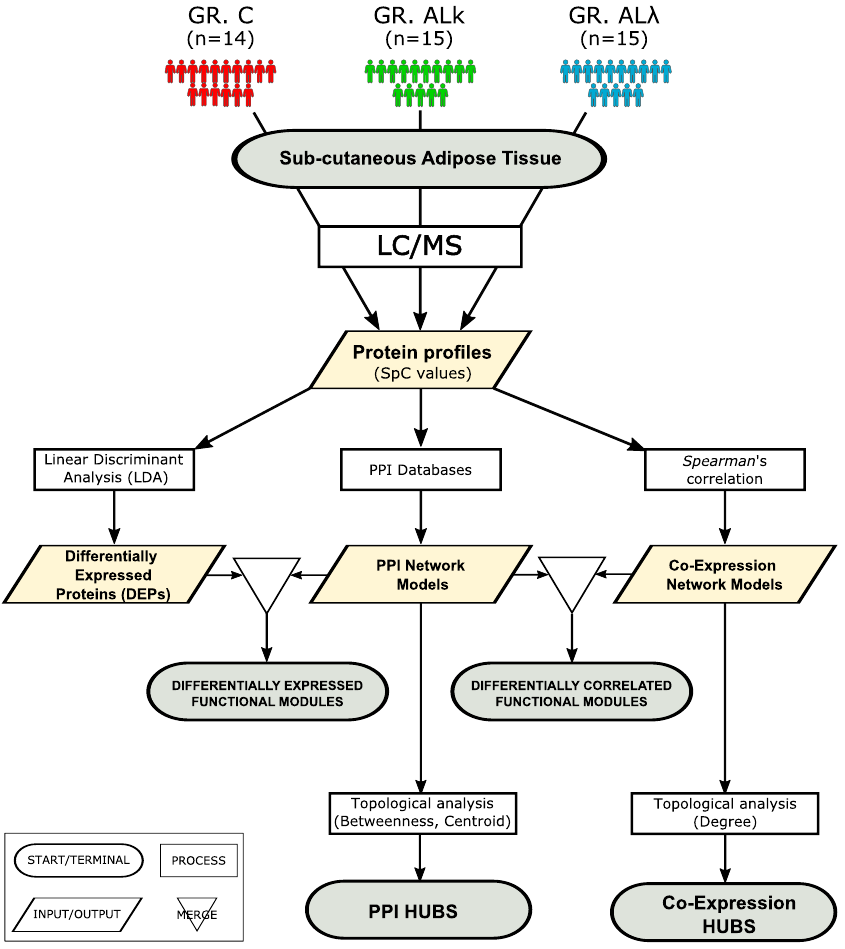
Figure 1. Workflow applied to investigate, at the proteomic system level, abdominal sub-cutaneous adipose tissues from control subjects (C, n = 14) and patients affected by AL κ (AL κ , n = 15) and AL λ (AL λ , n = 15)